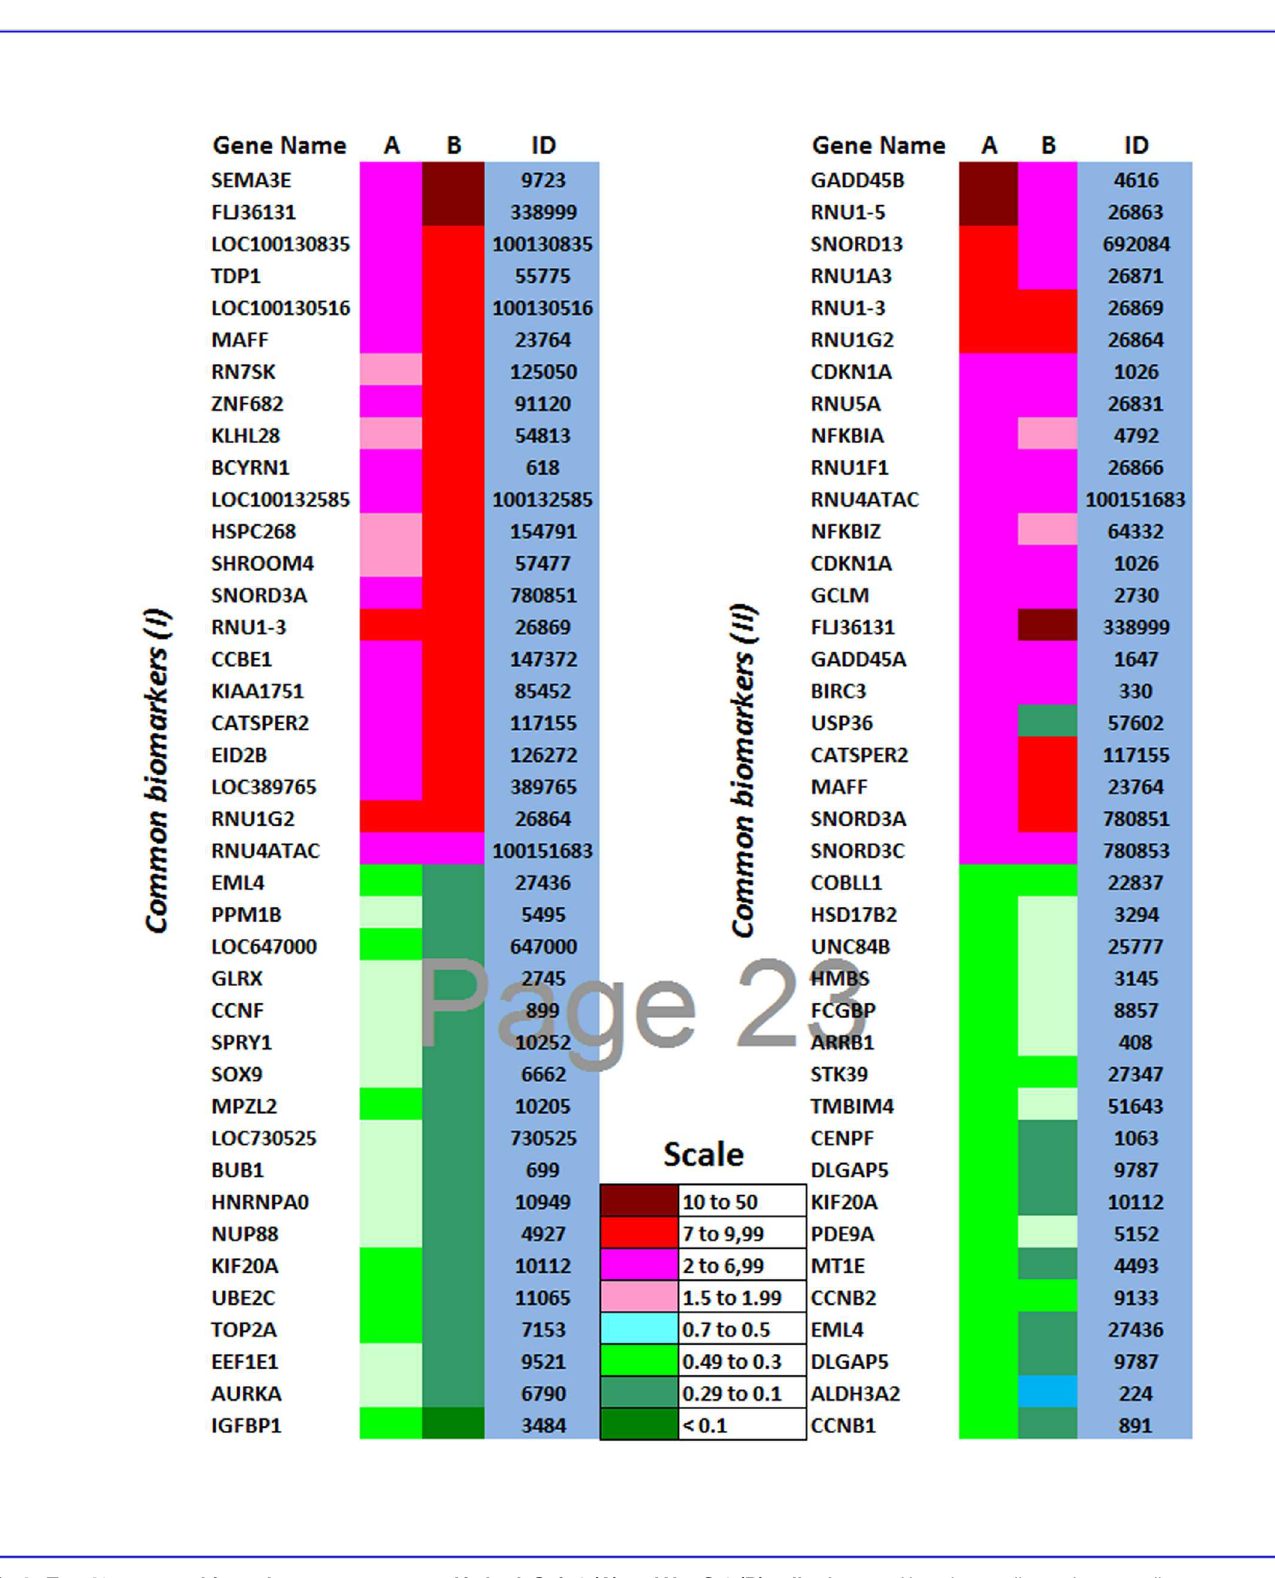
Fig 4. Top 40 common biomarker genes expressedin both Suit-2 (A) and HepG-2 (B) cells. Arrangedin a descending order accordingto gene expressionlevels in Suit-2 (I) and HepG-2 (II), respectively. doi:10.1371/journal.pone.0169335.g004 PLOS ONE | DOI:10.1371/journal.pone.0169335 January4,